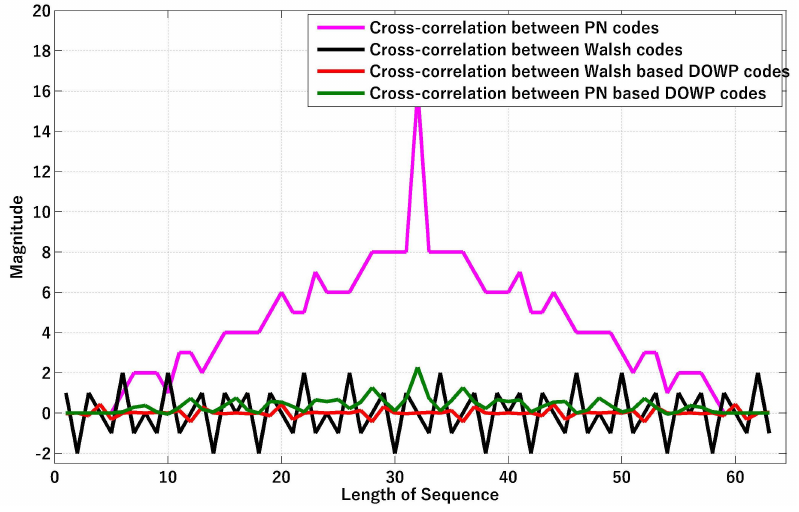
Figure 10. Cross-correlation Results of DOWP, Walsh, and PN codes.